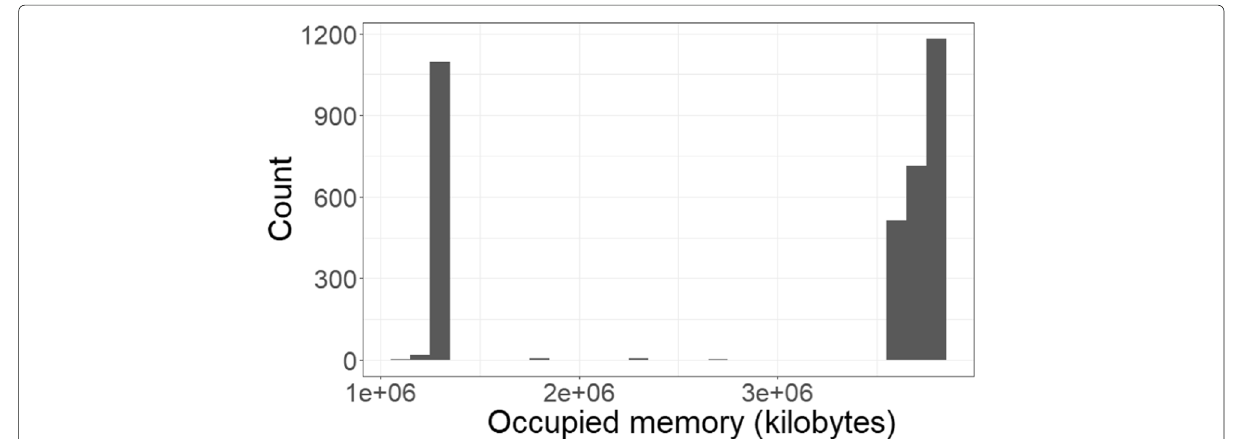
Fig. 10 Histogram of the memory usage of the MR